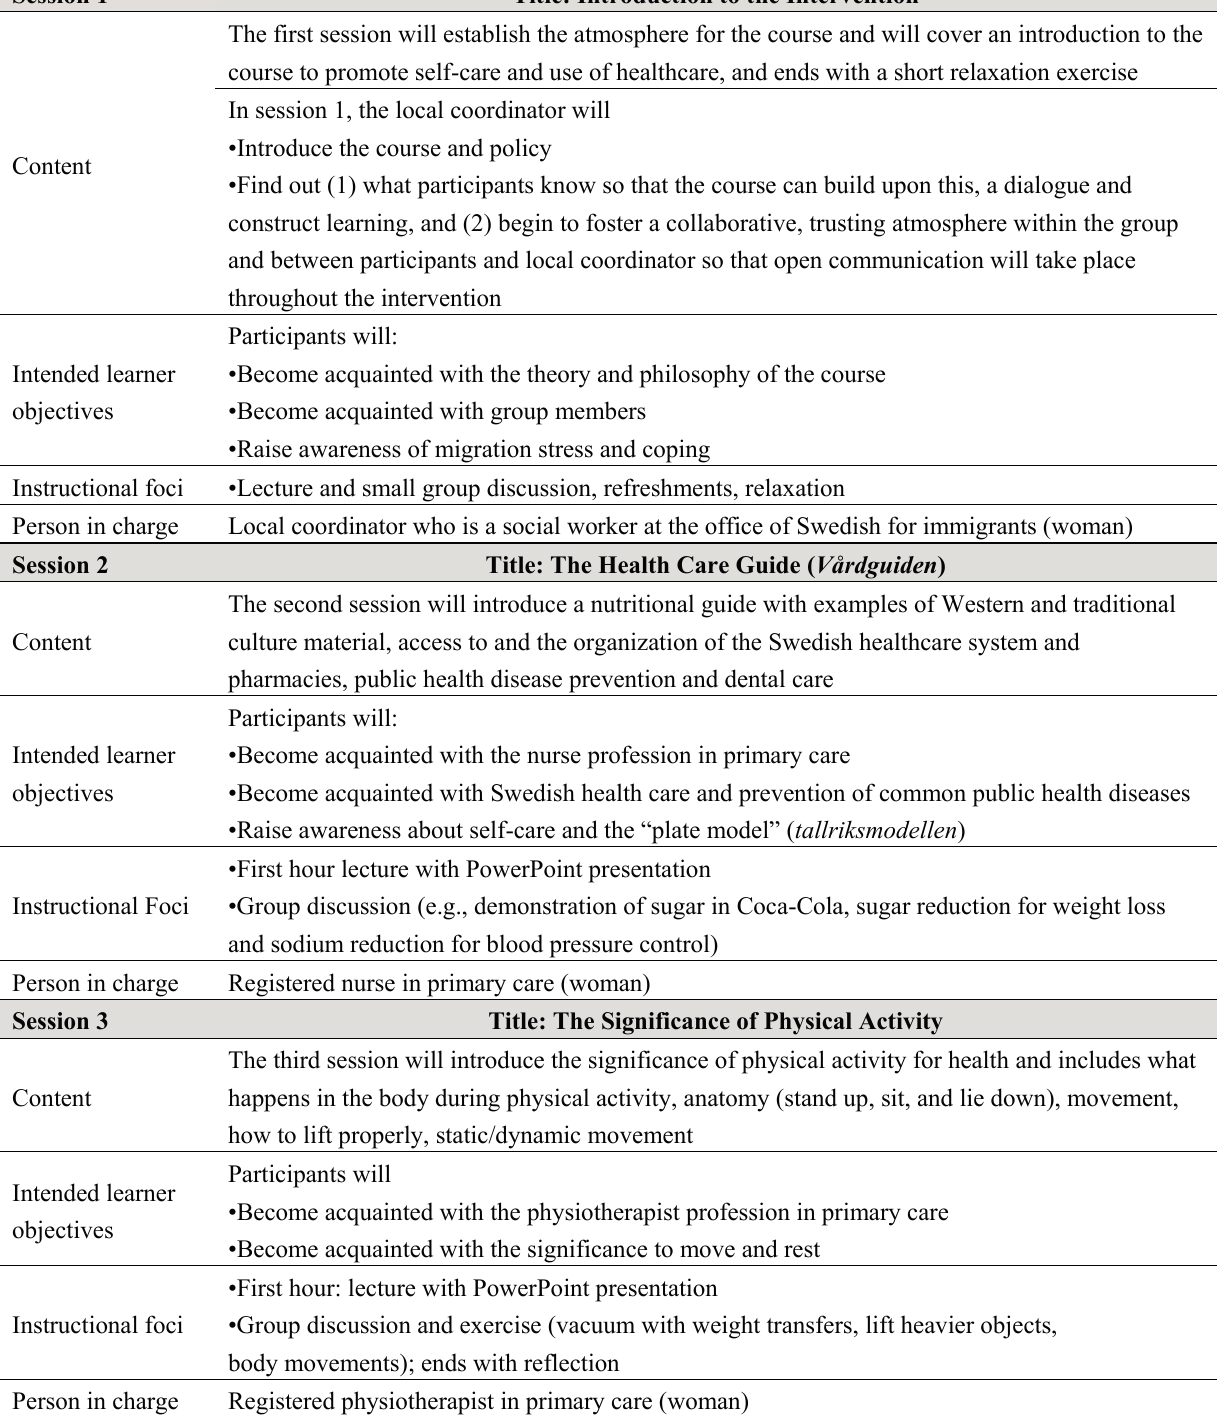
Table 1. The intervention presentation: each session with its content, objectives, instructional foci, and person in charge of the